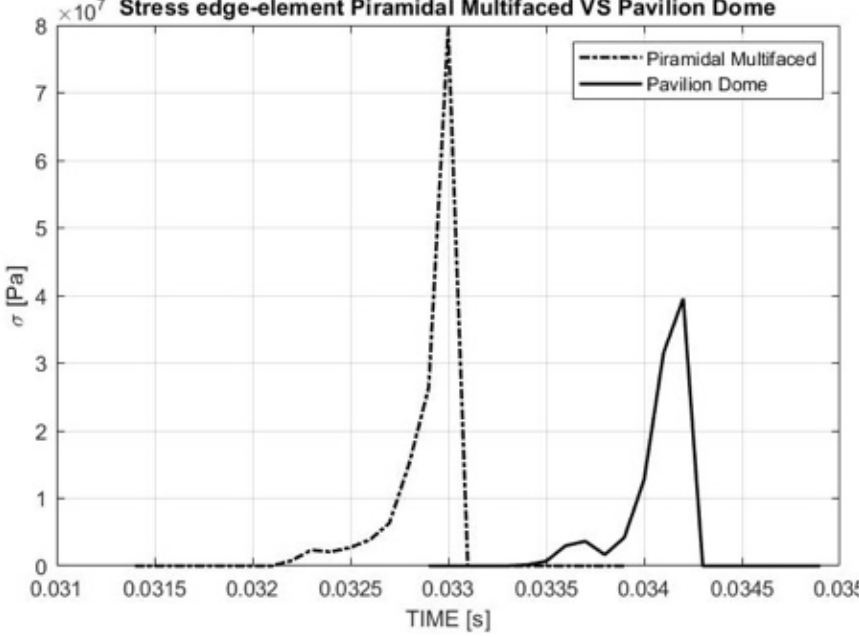
Figure 18. Pyramidal Multifaced VS Pavilion Dome Tailgate: Stress evaluation.